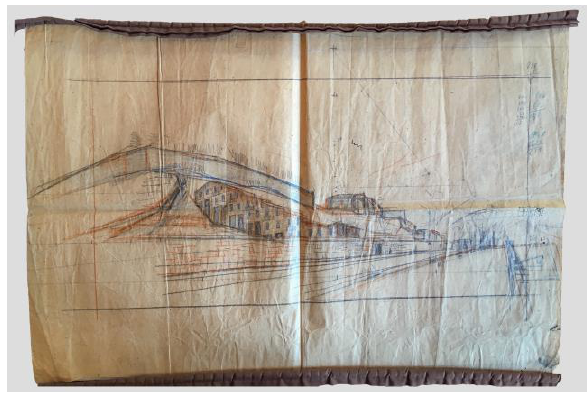
Figure 4. A perspective view of the first draft of the project, probably the version awarded by the INA-Casa and approved by the Urban Planning Commission of Bergamo on 10 March